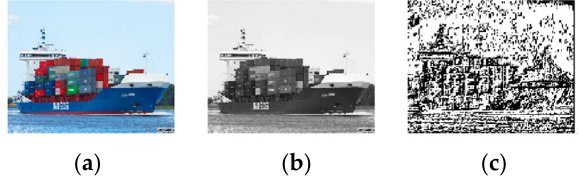
Figure 9. Illustration of the local binary pattern (LBP) feature using the self-built dataset: ( a ) Original image; ( b ) grayscale image; and ( c ) LBP feature.